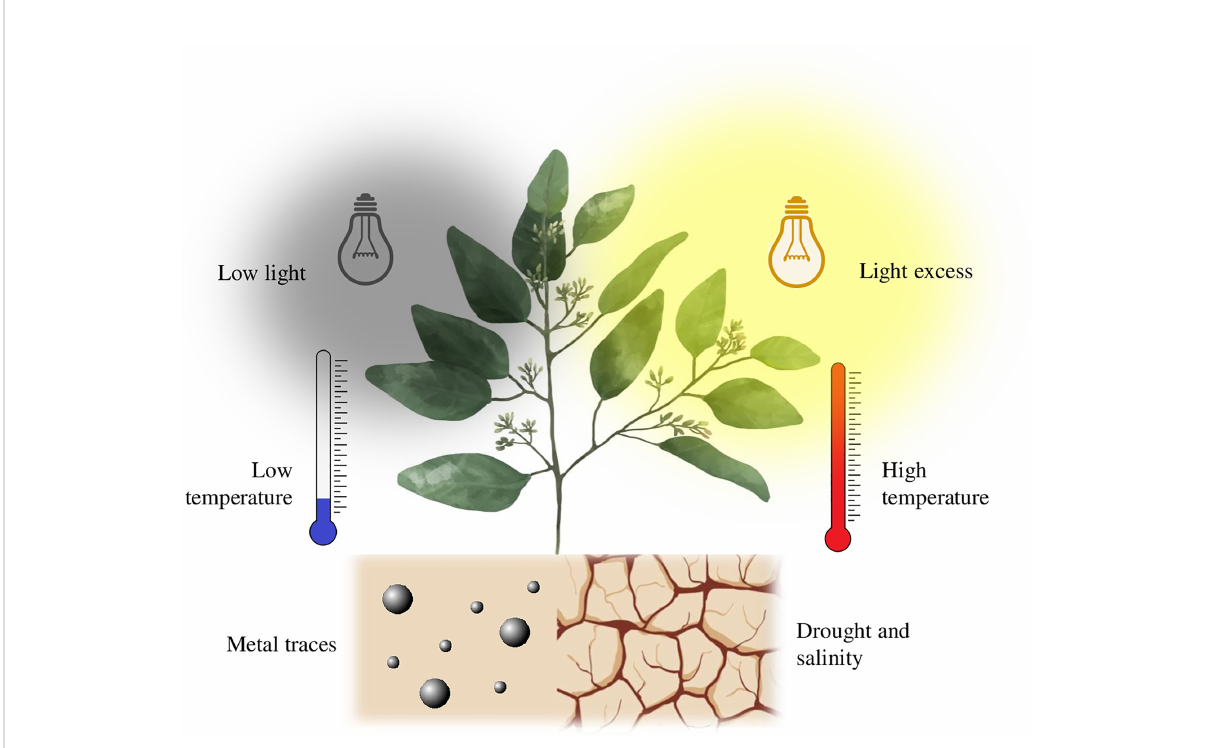
FIGURE 1 Drought and salinity, temperature, soil contamination and light stress on